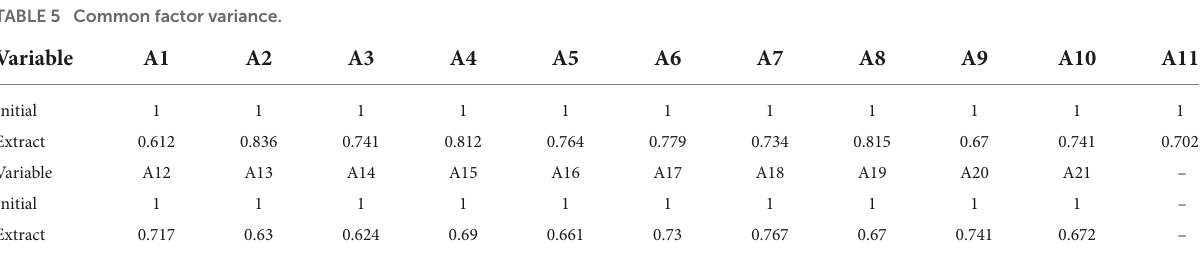
TABLE 5 Common factor variance.